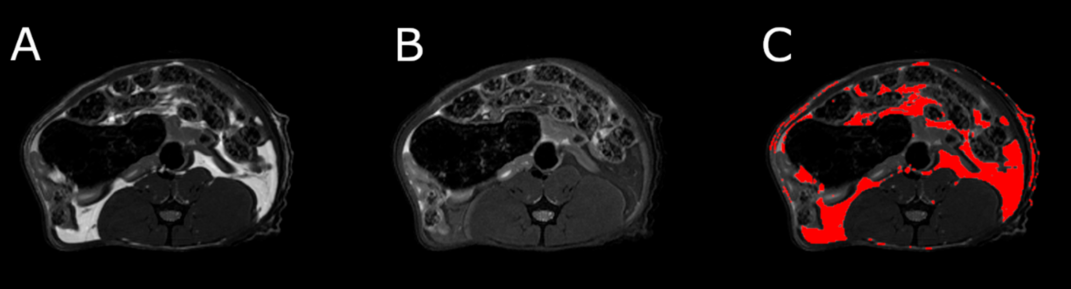
Figure 6. MRI scan of female ABA rat, the cross section of the abdomen at L4 level. ( A ) RARE image without fat suppression; ( B ) fsupRARE image with fat suppression; ( C ) segmentation result—adipose tissue marked in